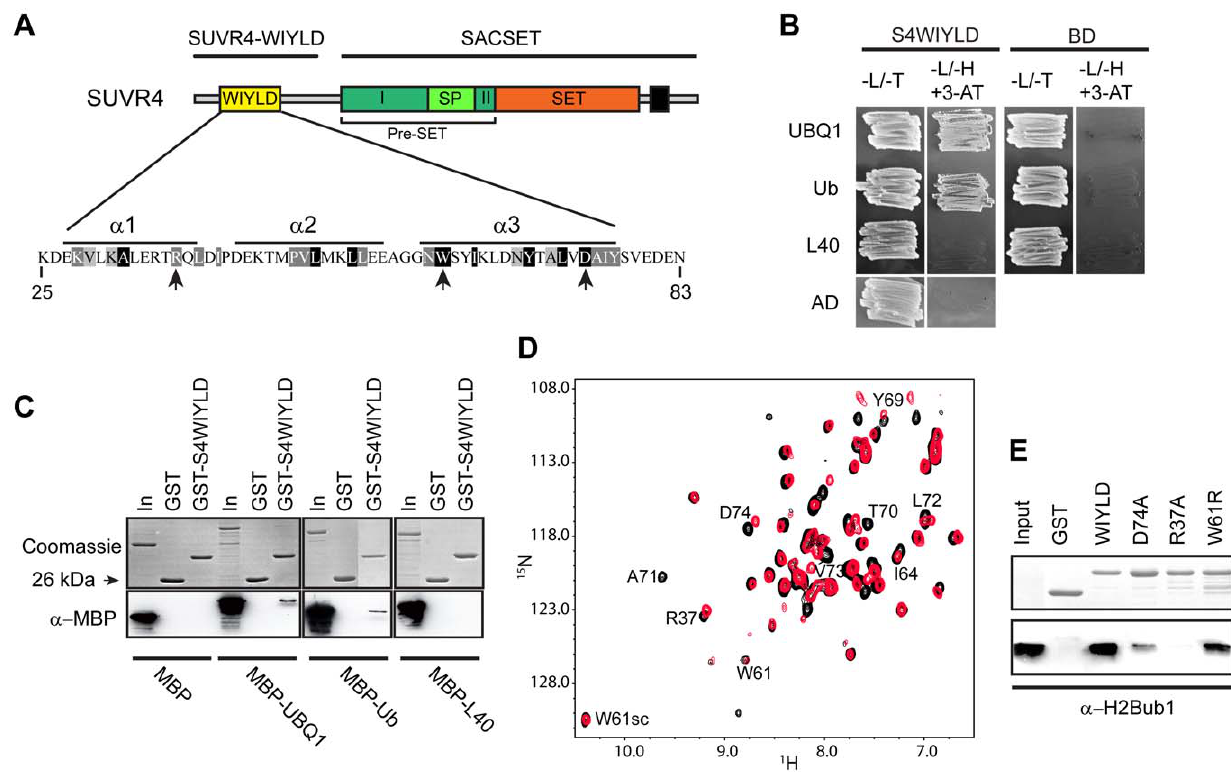
Figure 1. The WIYLD domain is a ubiquitin-binding domain. (A) Layout of the SUVR4 full-length protein, showing the different domains/ motifs and the regions included in the two constructs SUVR4-WIYLD and SACSET. SP, SUVR pre-SET; I, pre-SET I; II, pre-SET II; SET, SET domain. Black box indicates the post-SET domain [28].The amino acid sequence of SUVR4 from N 25 to K 83 encompassing the WIYLD domain, with conserved residues shaded in black, and residues mutated in this work indicated with arrowheads. (B) Yeast two-hybrid interaction test between SUVR4-WYILD and the full-length CDS of UBQ1, as well as the N-terminal ubiquitin (Ub) and the C-terminal ribosomal L40 moieties of UBQ1. –L/-T – medium selective for diploid colonies; -L/-T/-H + 3 AT – medium selective for protein-protein interactions. AD, control mating with empty prey vector; BD, control matings with empty bait vector. (C) GST-SUVR4-WIYLD immobilized on glutathione sepharose beads were used to pull down MBP, MBP- UBQ1, MBP-Ub or MBP-L40 from bacterial lysate. Pull-down reactions were separated on SDS-PAGE, blotted onto a PVDF membrane and detected with an anti-MBP antibody. IN, input (5%); GST, GST negative control. (D) [ 1 H, 15 N]-HSQC spectrum of SUVR4-WIYLD in its free form (black), and after the addition of excess ubiquitin to a molar ratio of 1:3 (red). The assigned amino acid residues are indicated. (E) GST pull-down of H2Bub1. GST- SUVR4-WIYLD was mutated at positions D74, R37 and W61 and used for GST pull-down of core histones from calf thymus. The pull down reactions were blotted onto a PVDF membrane and probed with an antibody against ubiquitinylated H2B